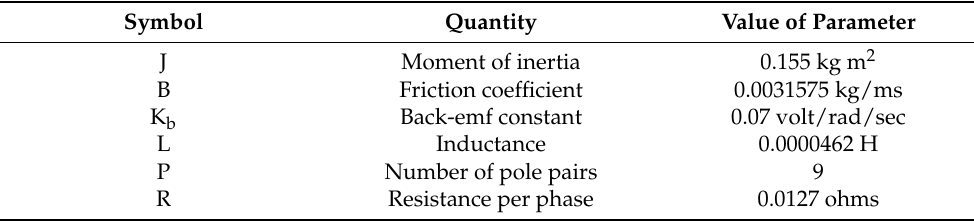
Table 1. Parameters of the PM BLDC